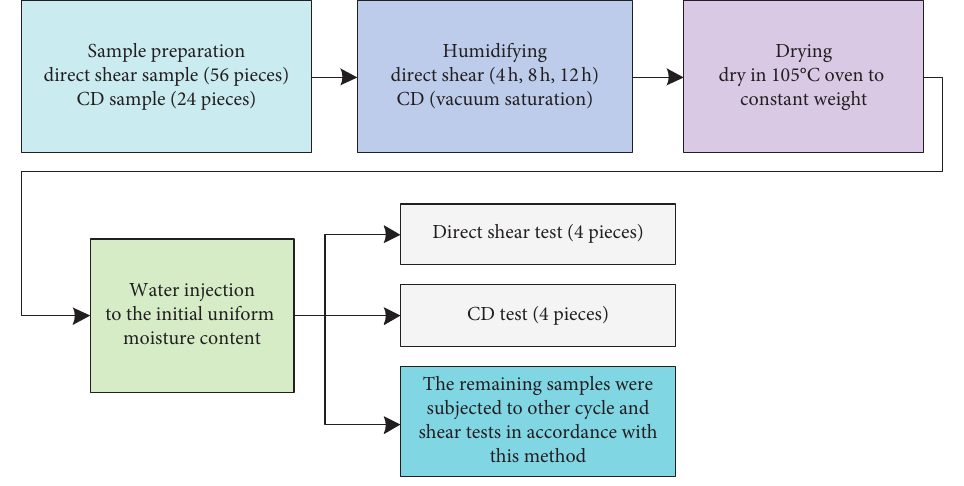
Figure 3: Implementation roadmap of a dry and wet